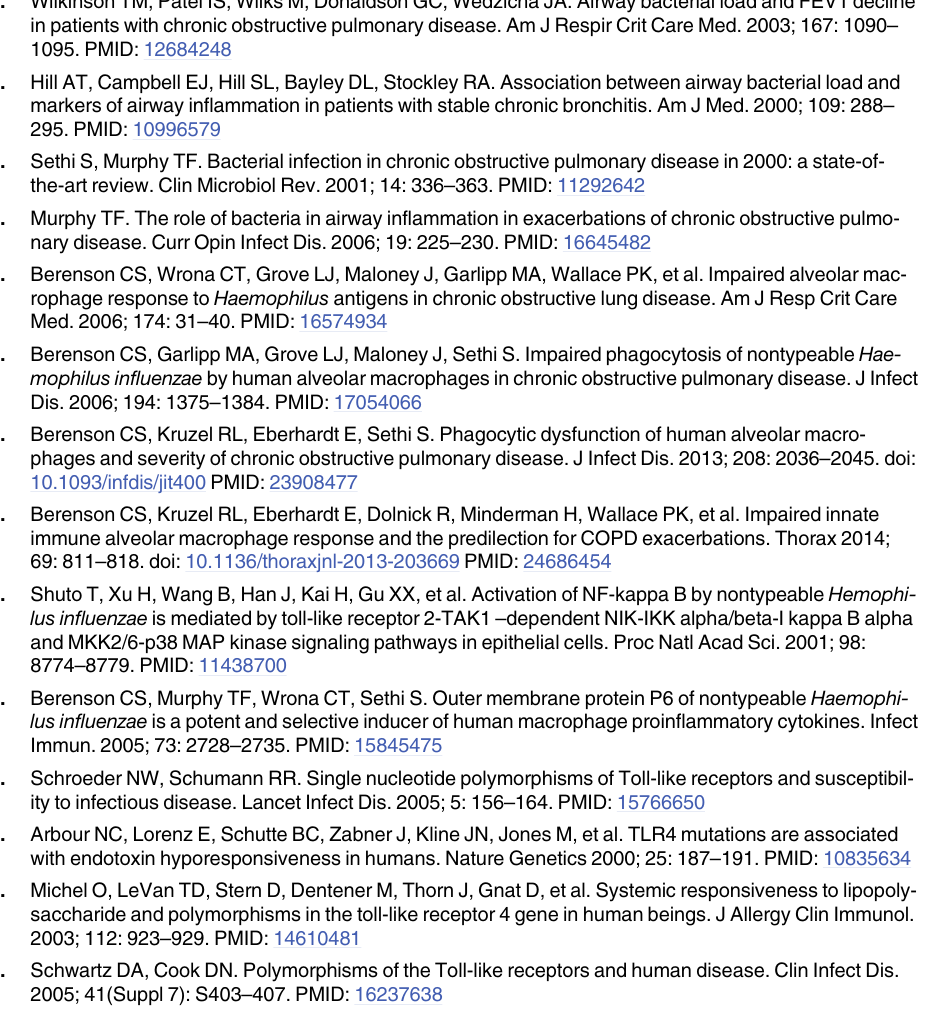
IL-8 (pg/ml) induction of alveolar macrophages 10